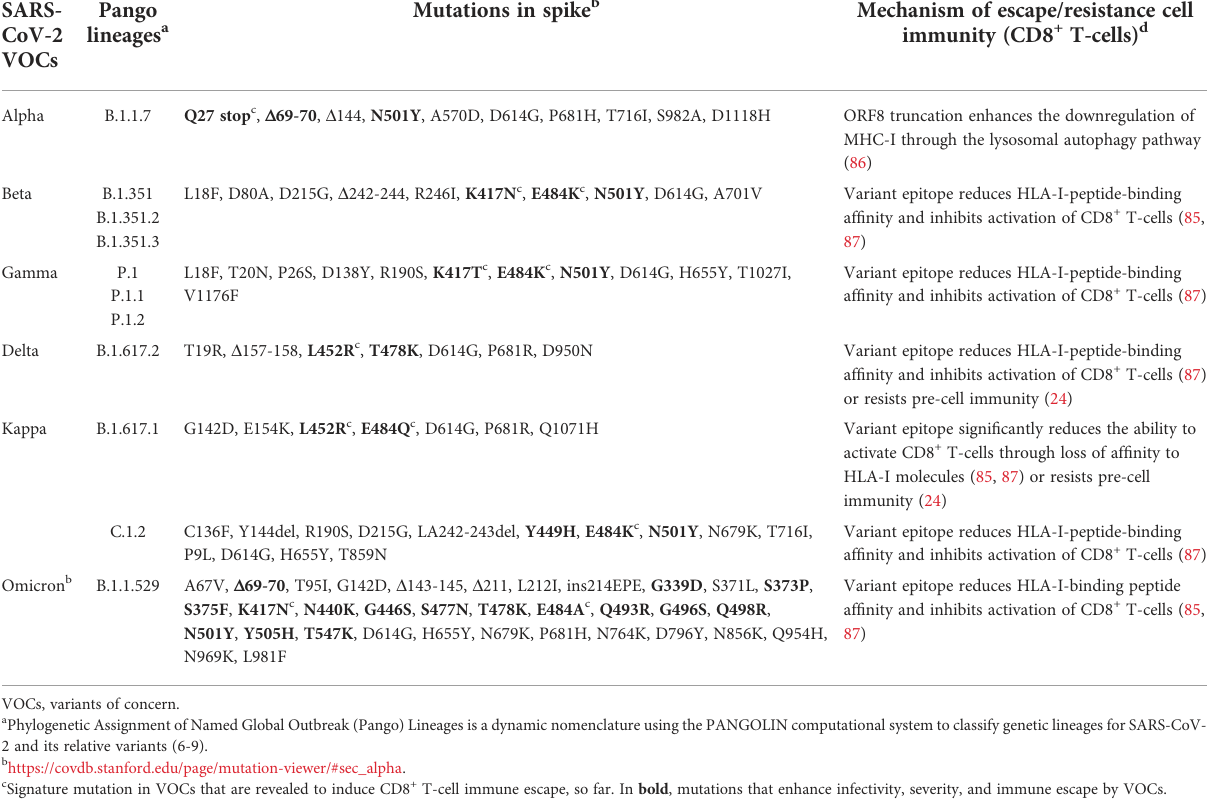
TABLE 1 The signature mutations of VOCs and mechanism of immune